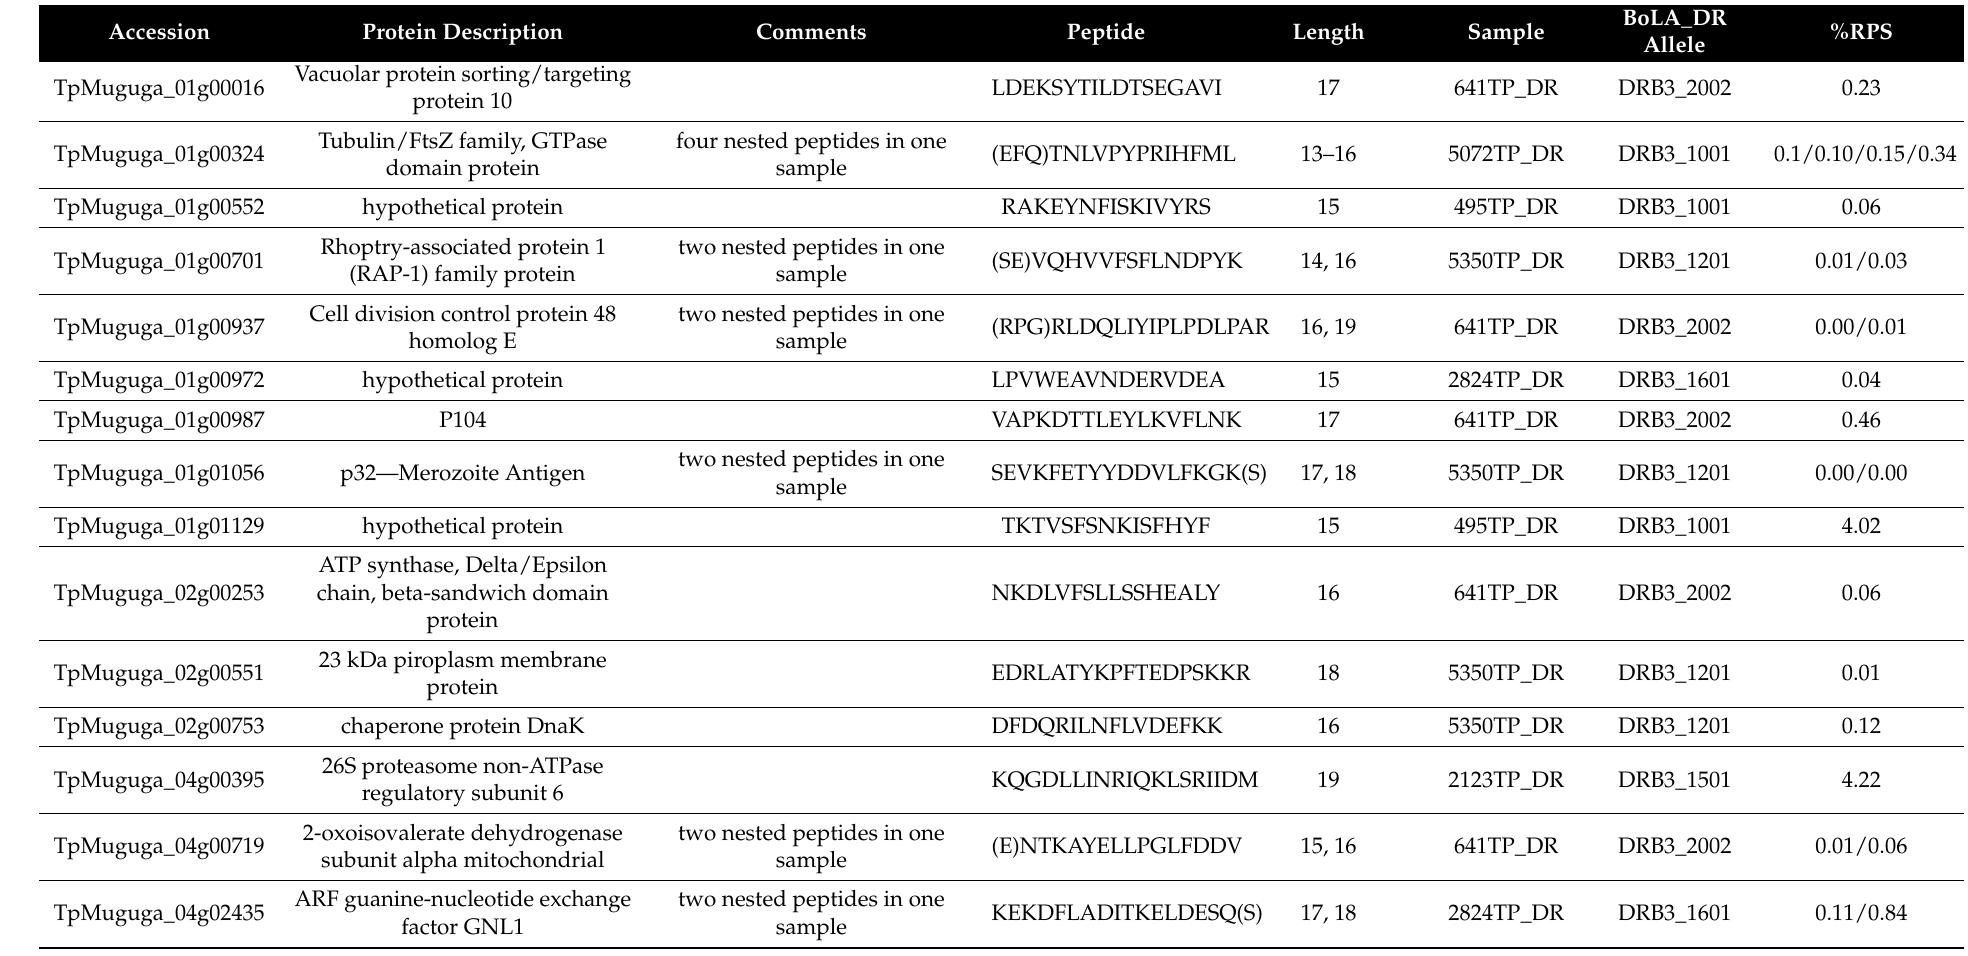
Table 4. Predicted BoLA-DR presented T. parva peptides identified in this study. For each peptide, the accession number and description of the protein from which it is derived are shown in columns A and B, and specific comments about particular proteins are given in column C. Column D–H provide details about the individual peptides, including its sequence, length, the sample it was identified in, the BoLA-DR allele predicted to present the peptide and the predicted percent rank binding score